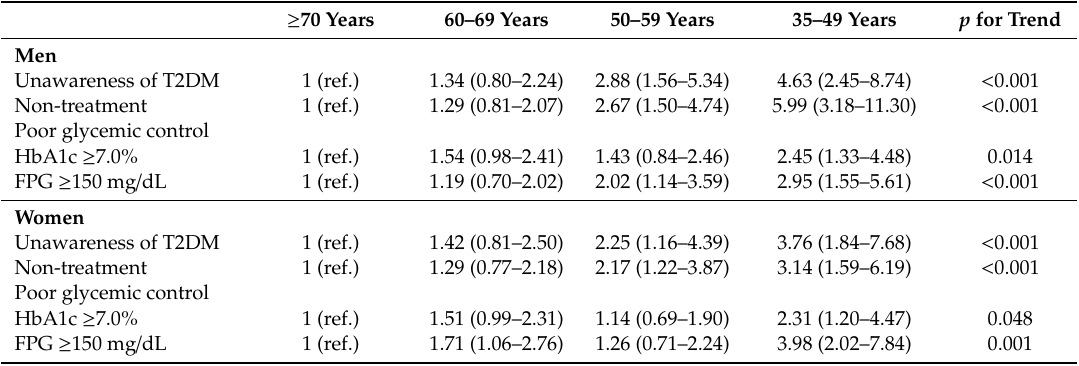
Table 4. Control of cardiometabolic parameters according to age groups among patients with T2DM.